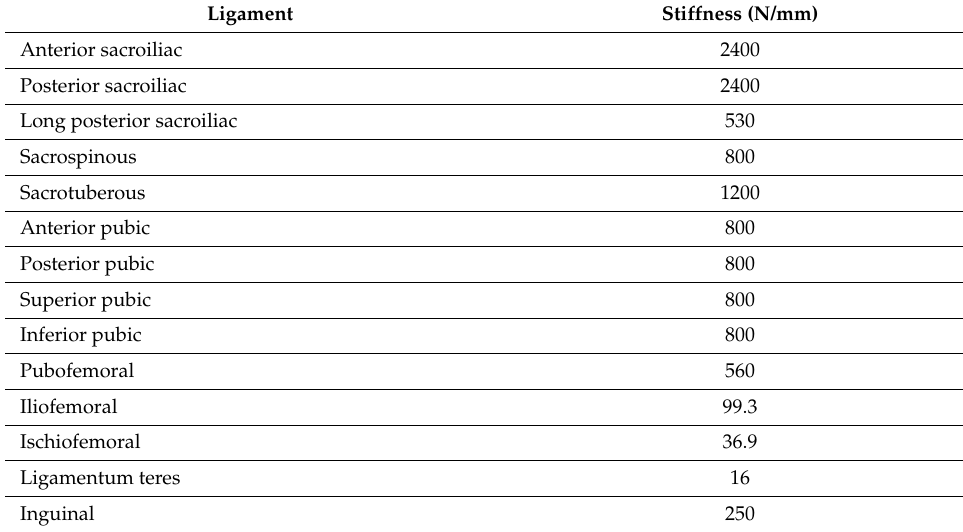
Table A3. Ligaments’